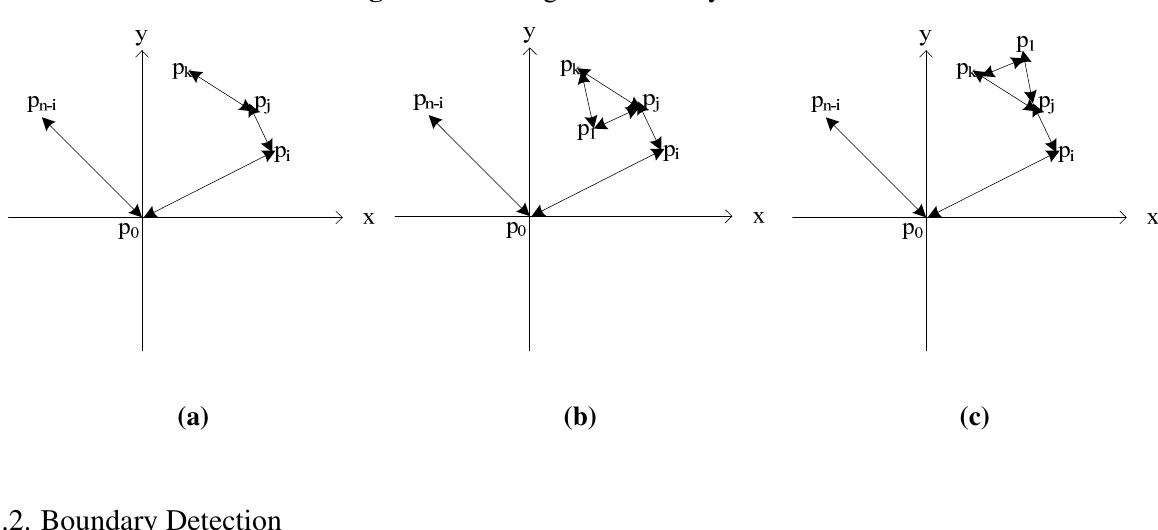
Figure 4. Finding the boundary sensors.